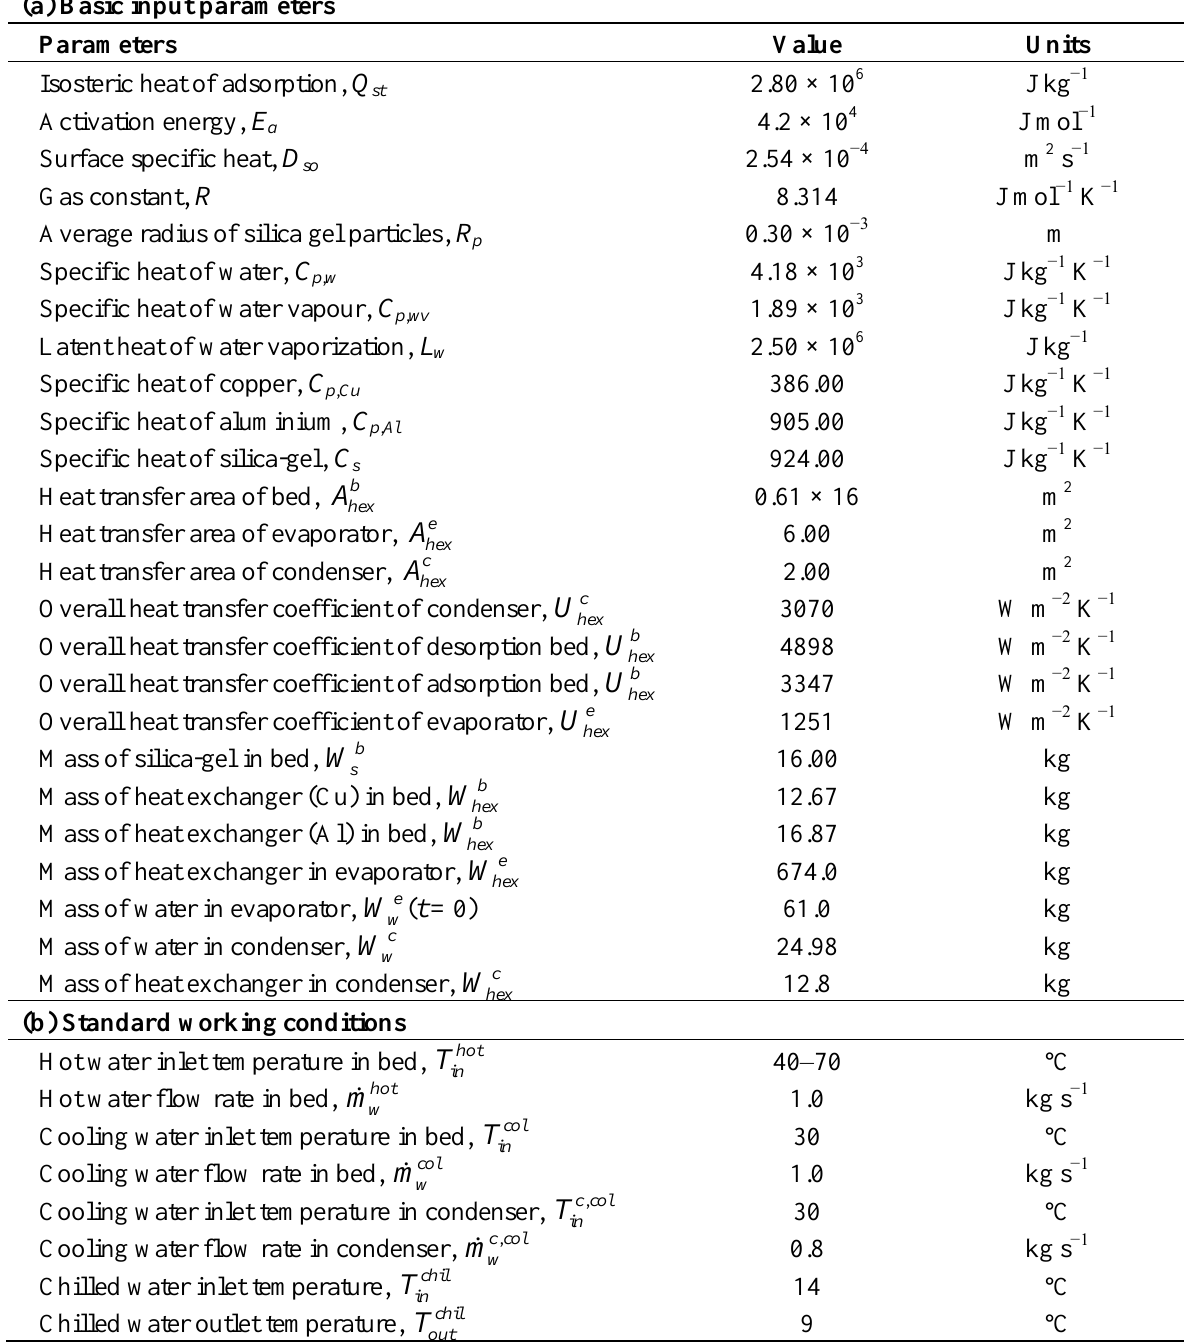
Table 2. Basic input parameters and standard working